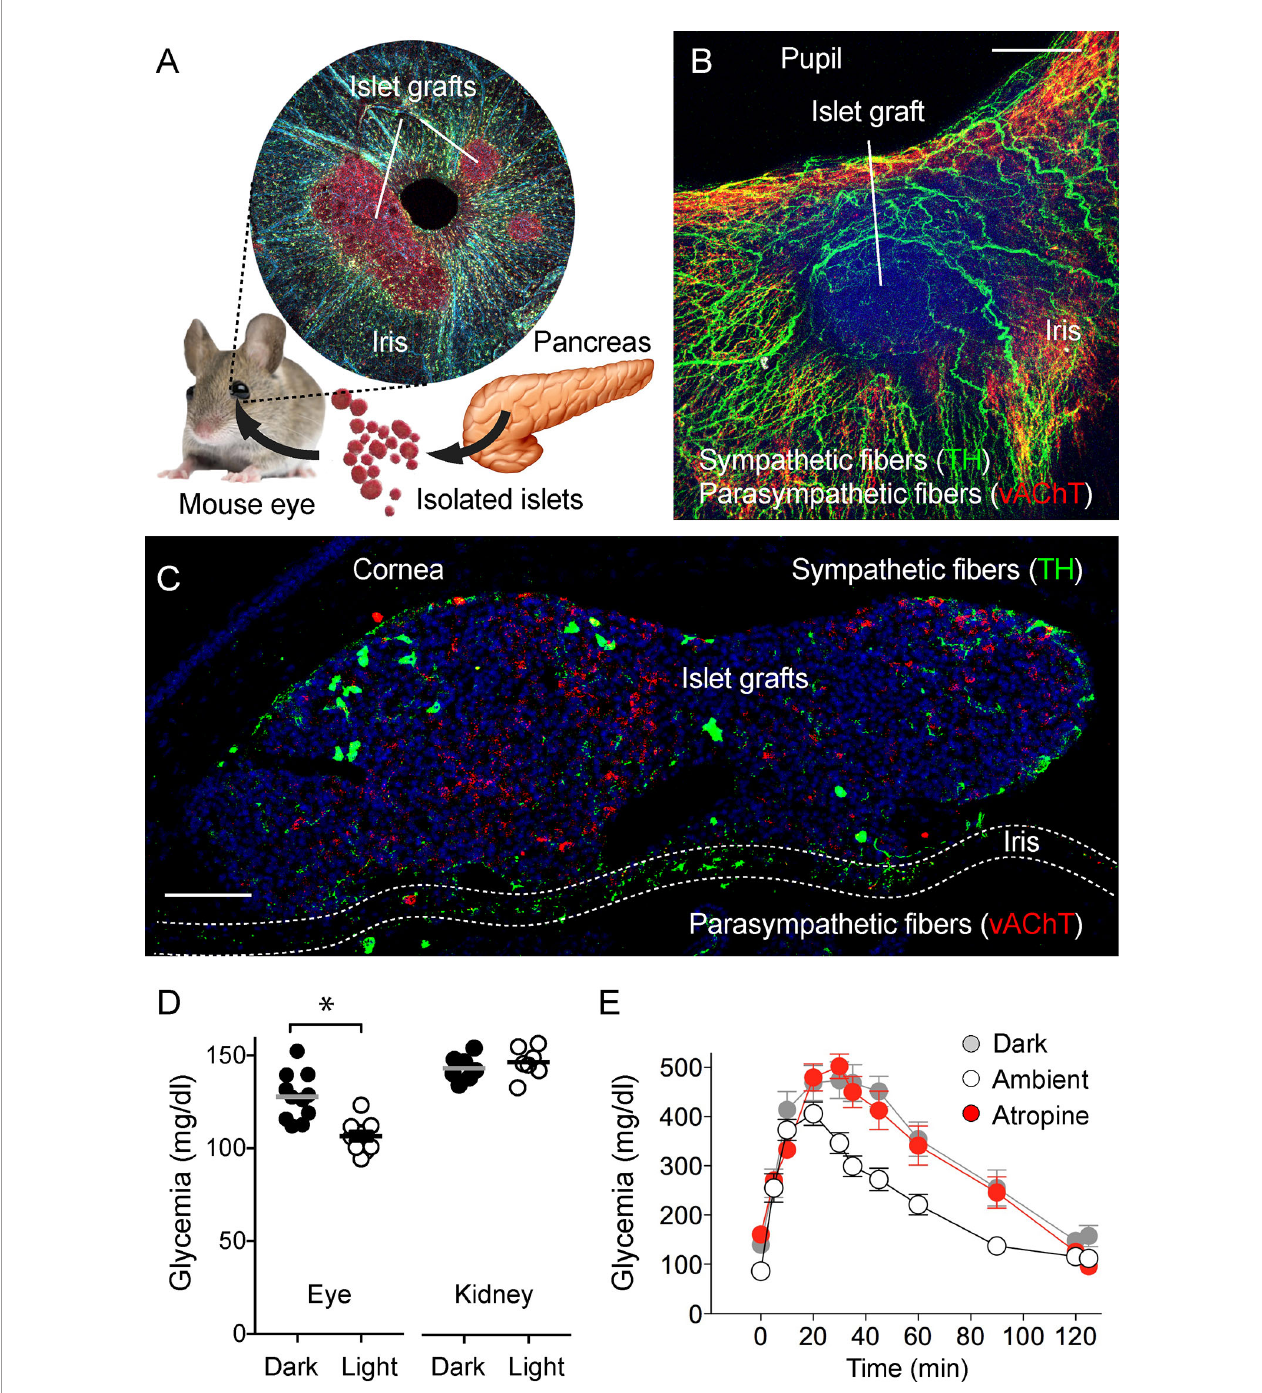
FIGURE 5 | Eye model for imaging innervation of pancreatic islet grafts [photomicrographs are from experiments conducted by Dr. Rayner Rodriguez-Diaz ( A – C , unpublished data], data in (D) and (E) adapted and modi fi ed from Figure 4 in Rodriguez-Diaz et al., 2012). (A) Schematic representation of islet transplantation into the anterior chamber of the eye. Islets isolated from the pancreas are transplanted into the mouse eye. Microphotograph of an iris wholemount with islet grafts. (B) Z-stack of confocal images of a wholemount of the mouse iris with an islet graft immunostained for TH (green) and vAChT (red); scale bar 50 µm. (C) Confocal image of a cross-section of the mouse eye showing two islet grafts, stained for TH (green), vAChT (red), and DAPI (blue); scale bar 50 µm. (D) Plasma glucose levels in mice transplanted with islets in the anterior chamber of the eye or under the kidney capsule, in ambient light or in the dark (*p < 0.05, paired Student ’ s t-test). (E) Glucose excursion during an IPGTT of transplanted mice performed in the dark (gray symbols), ambient light (open symbols), or in ambient light after topical application of the muscarinic receptor antagonist atropine (red